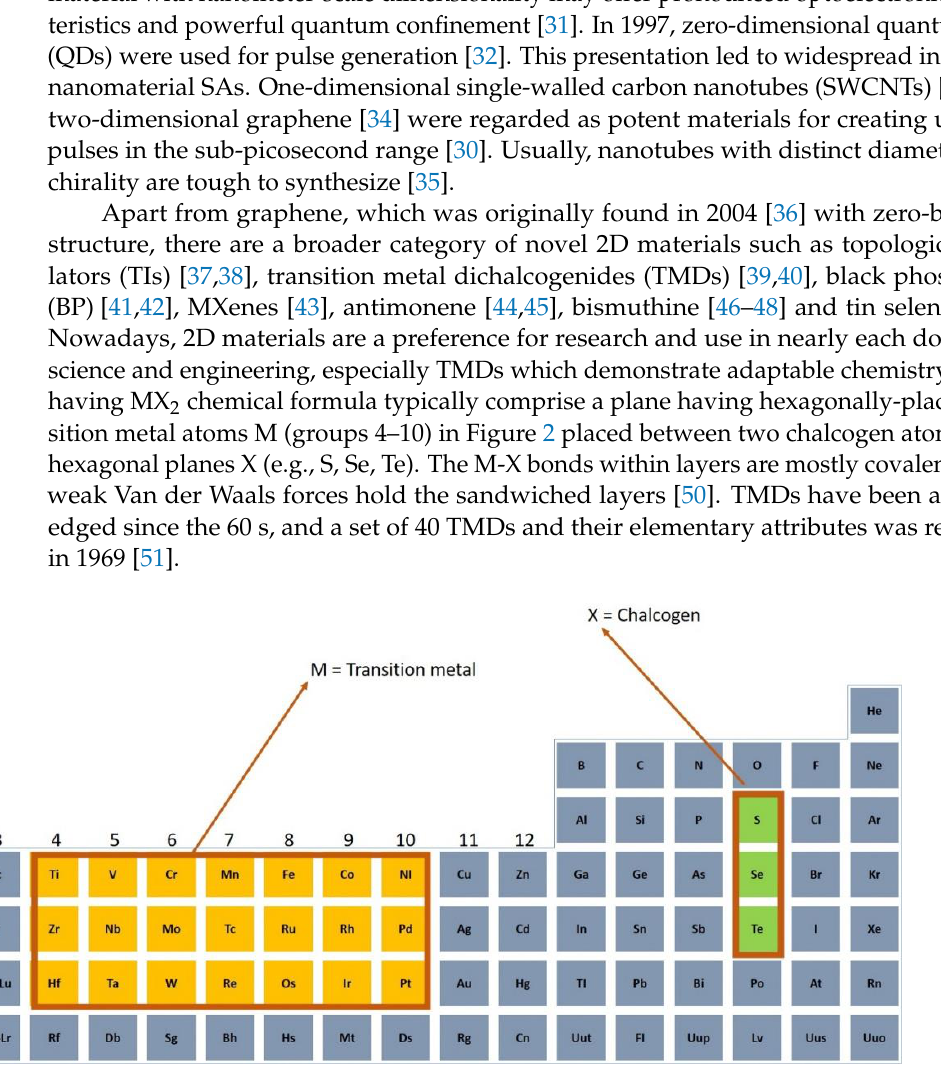
Figure 2. Periodic table showing TMDs materials with its components of transition metals M and three chalcogen X ele- ments.